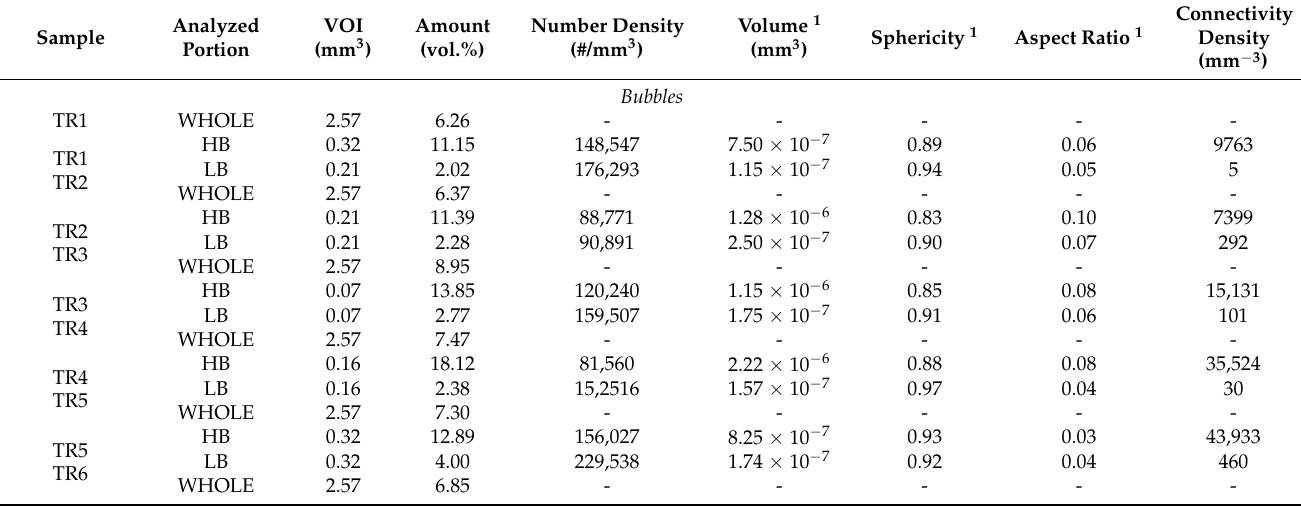
Table 1. Results of 3D image